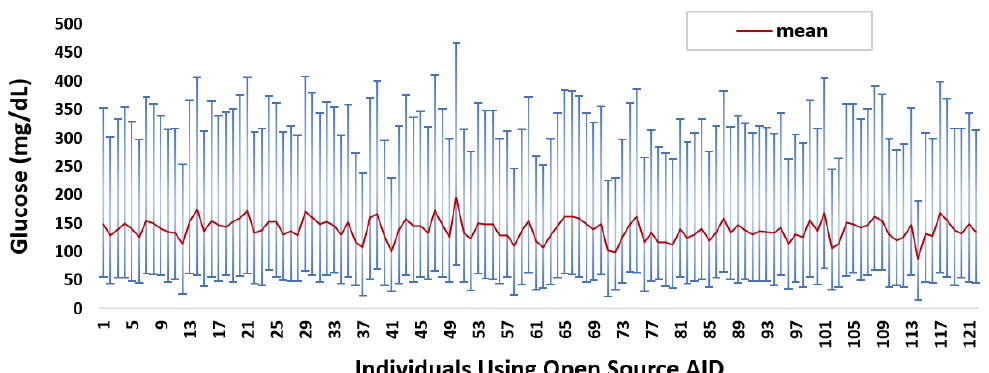
Figure 1. Glucose mean and distribution for insulin-requiring individuals using open-source AID systems. Total number of individuals ( n ) = 122. Average glucose mean and SD across the individuals is 139 ±